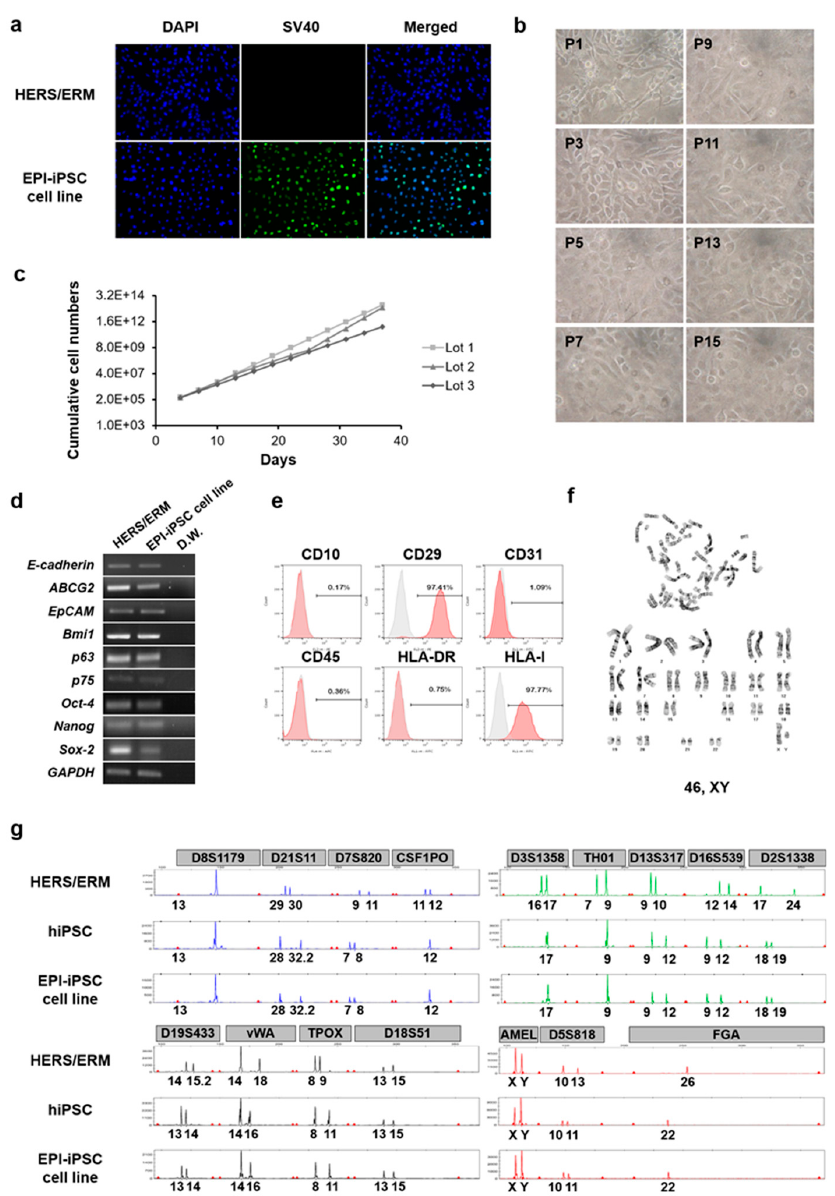
Figure 4. Characterization of dental epithelial-like stem cell lines derived from hiPSC. ( a ) Immunofluorescence staining for the expression of SV40 in the EPI-iPSC cell line. Primary HERS / ERM cells did not express SV40, whereas the established EPI-iPSC cell line expressed SV40. ( b ) Morphology and passaging of the EPI-iPSC cell line. EPI-iPSC-SV40 showed the typical epithelial cell-like shape and clonal expansion until passage 15. The morphology was maintained through subculture. Magnifications are at 400 × . ( c ) Growth of three EPI-iPSC-SV40 lines. Cumulative cell numbers of EPI-iPSC showed that they maintained stable proliferation for 40 days. ( d ) Expression of epithelial stem cell and stemness-related genes in the EPI-iPSC cell line (passage 10). EPI-iPSC cell line was positive for E-cadherin , ABCG2 , EpCAM , Bmi1 , p63 , and P75 , which are epithelial stem cell markers, and Oct-4 , Nanog , and Sox-2, which are stemness-related markers. ( e ) FACS analysis of the EPI-iPSC cell line (passage 10). EPI-iPSC was positive for CD29 and HLA-I, and negative for CD10, CD45, HLA-DR, and CD31. ( f ) Karyotype of the EPI-iPSC cell line. The EPI-iPSC cell line at passage 10 showed a normal karyotype with 46, XY. ( g ) Origin of the EPI-iPSC cell line. Microsatellite (STR) analysis, which is a PCR-based microsatellite method, showed that the differentiated EPI-iPSC cell line was derived from hiPSC. All data were obtained from three replicates.